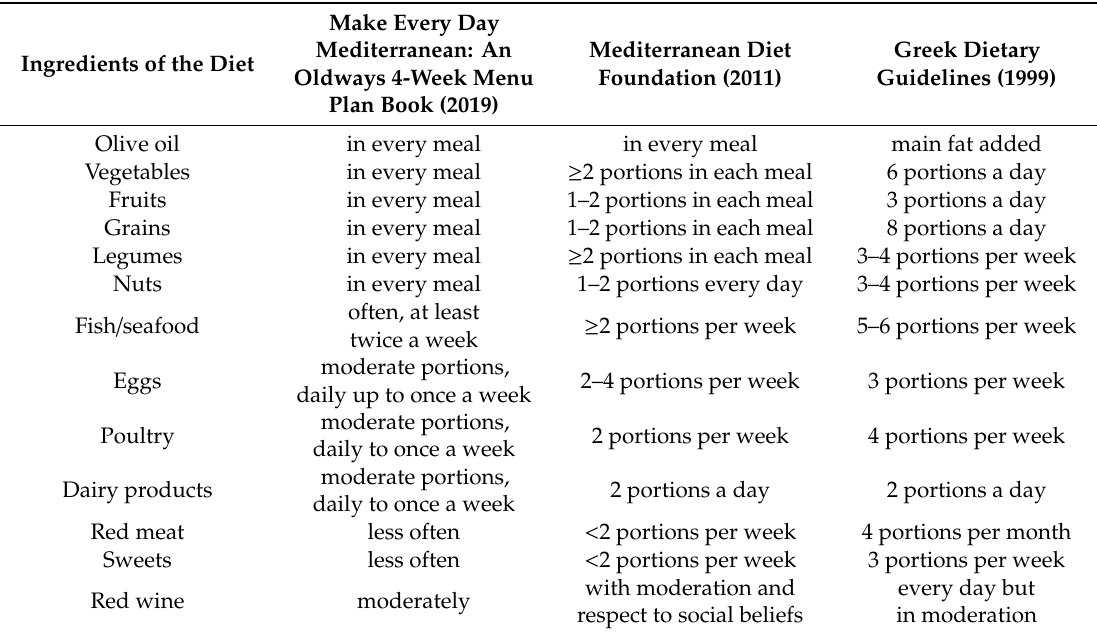
Table 1. Recommended portion sizes and the frequency of consumption of products recommended in the Mediterranean